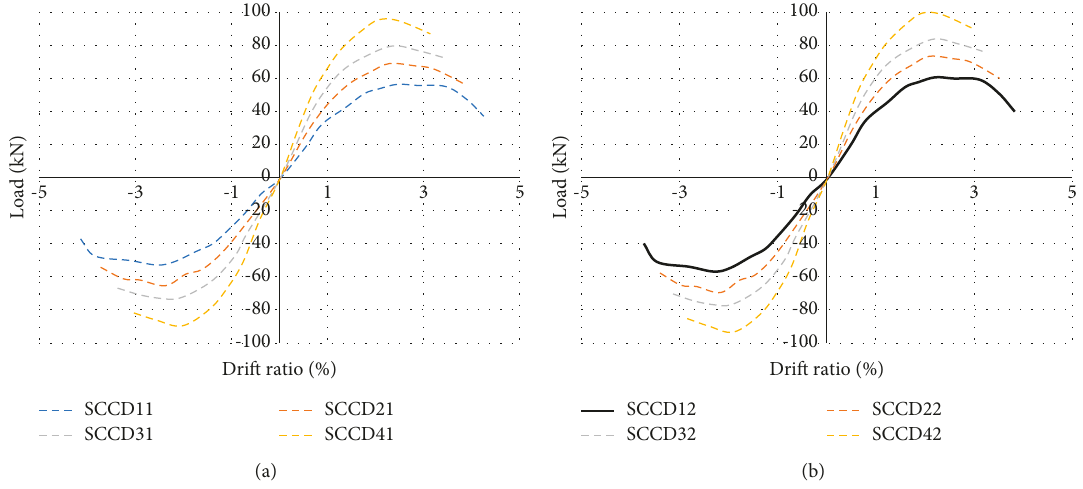
Figure 12: Backbone curve of load-drift ratio: (a) without drop panel and (b) with drop panel.